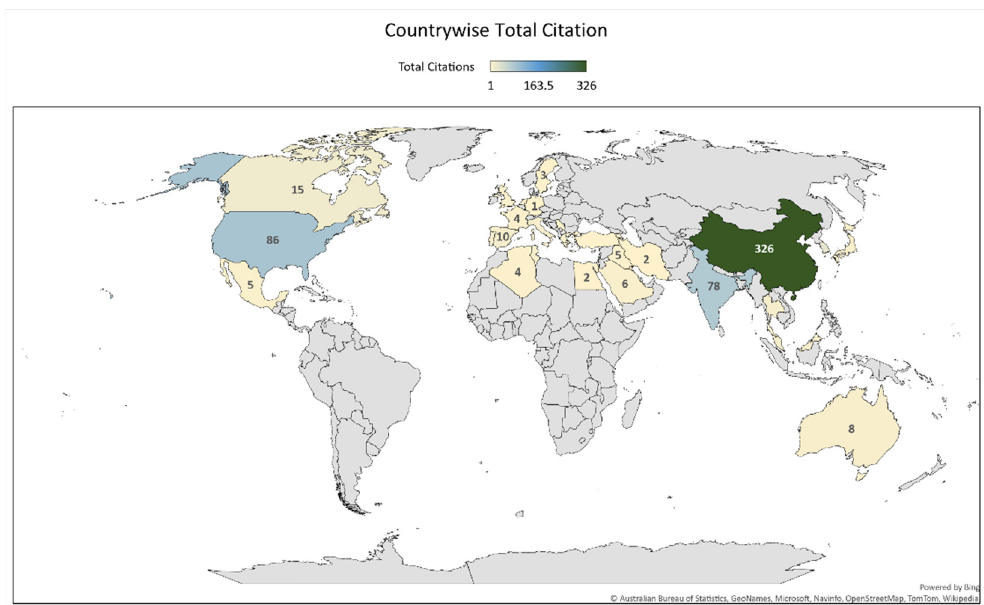
Figure 5. The total citations per country.